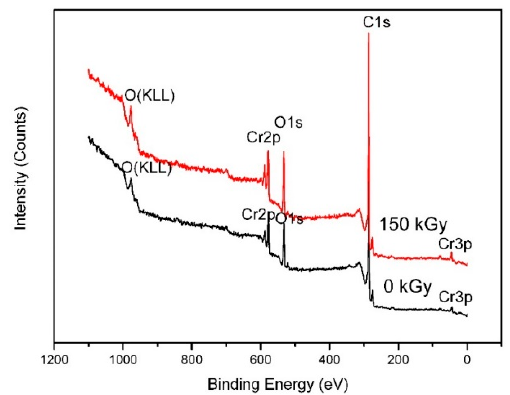
Figure 6. XPS spectra of the sample (1000 °C, 1 h) before and after gamma ray irradiation.